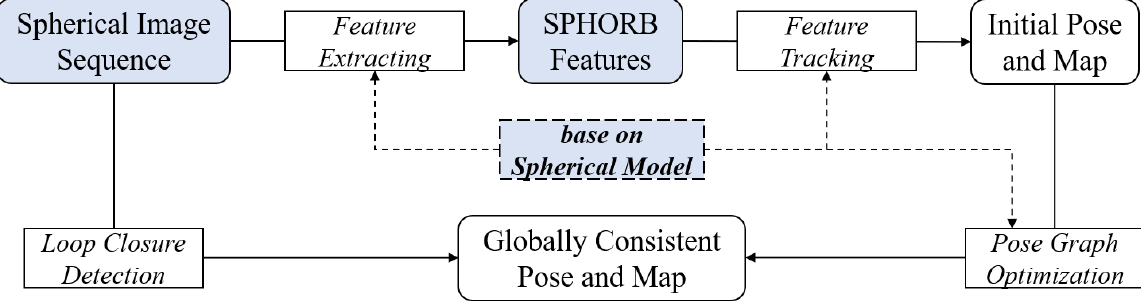
Figure 6. Framework of panoramic visual SLAM algorithms. Improvements to the classical framework are shown in